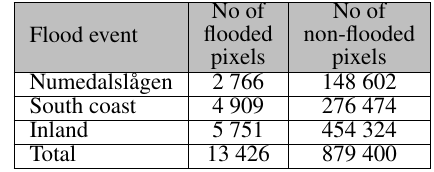
Table 2. Training data for the flood detection algorithm.